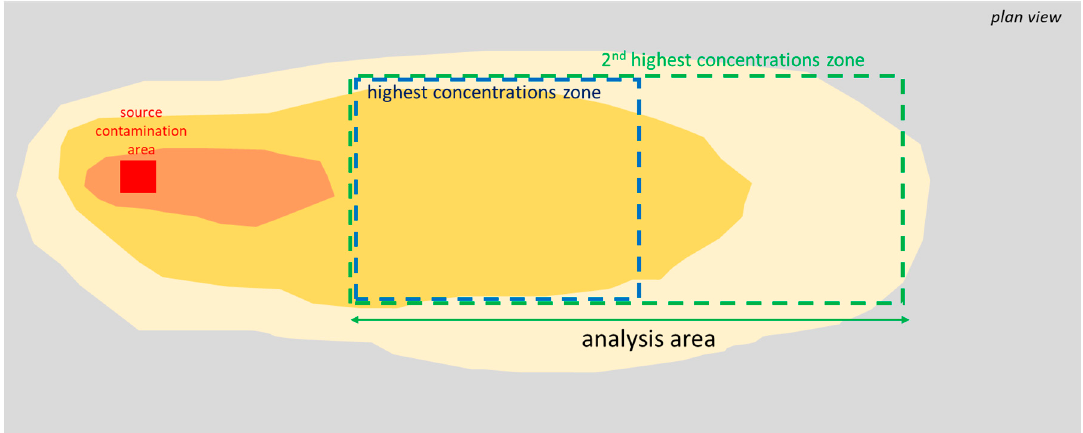
Figure 5. Modeling domain of the SRM approach using “plume analysis” as the analysis type.